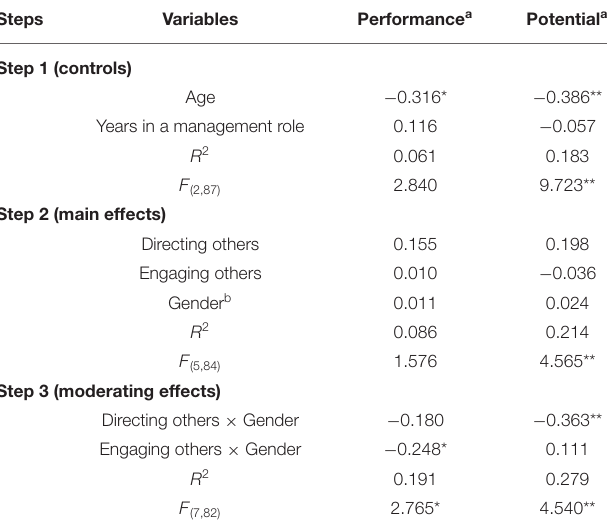
TABLE 3 | Results of moderated regression analyses.